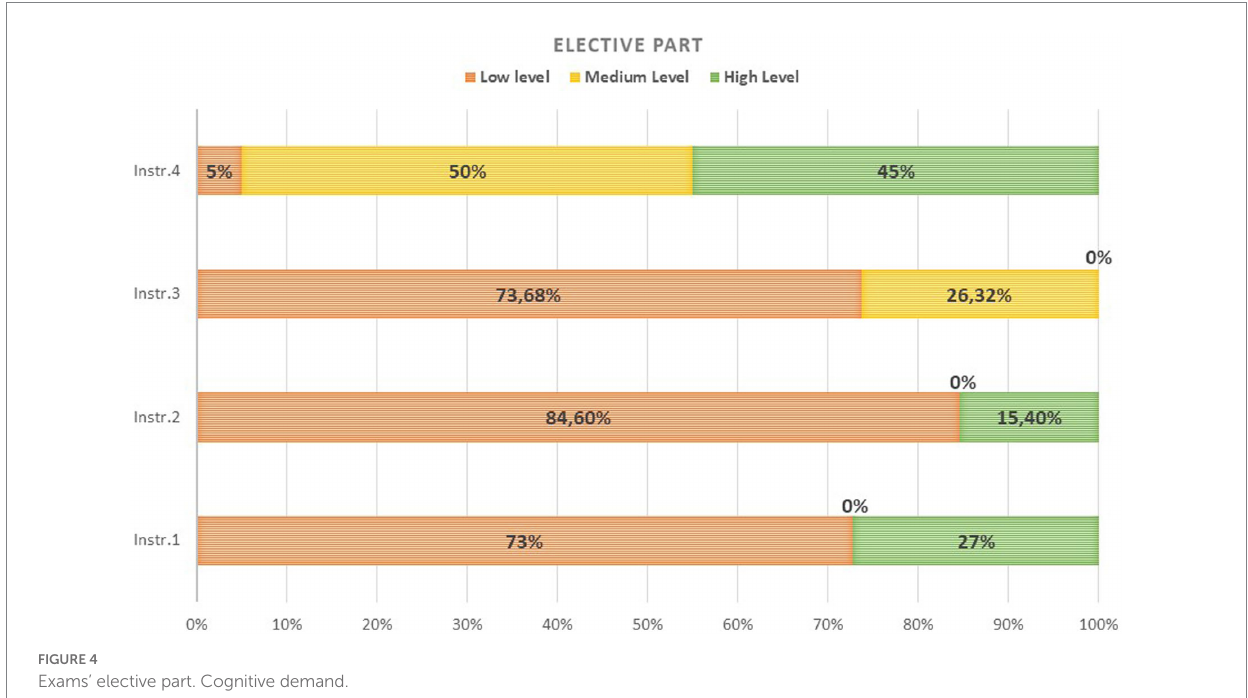
FIGURE 4 Exams’ elective part. Cognitive